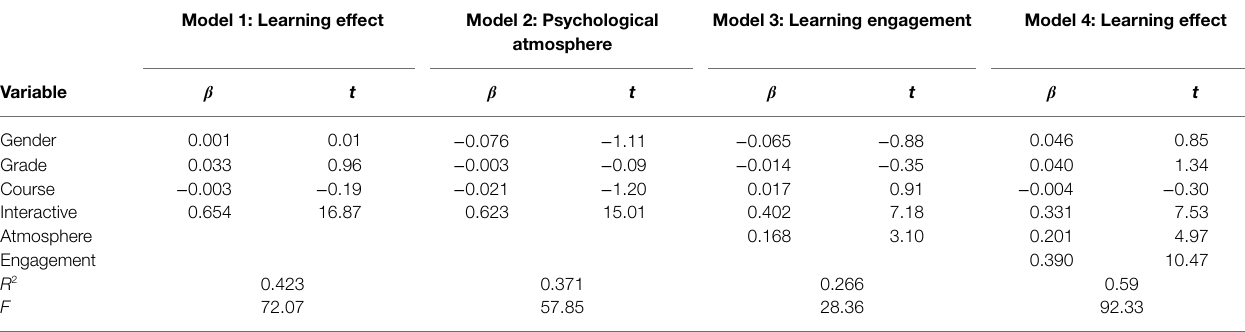
Model 3: Learning engagement Model 4: Learning atmosphere